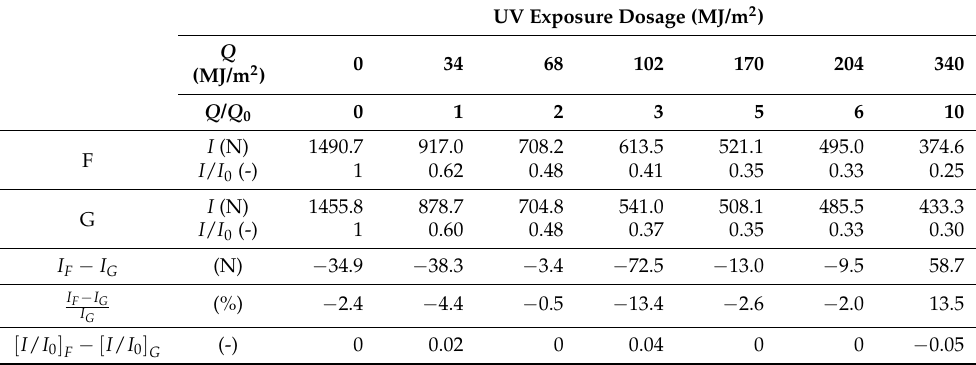
Table 4. Difference of tensile strength affected by water repellency (Samples F and